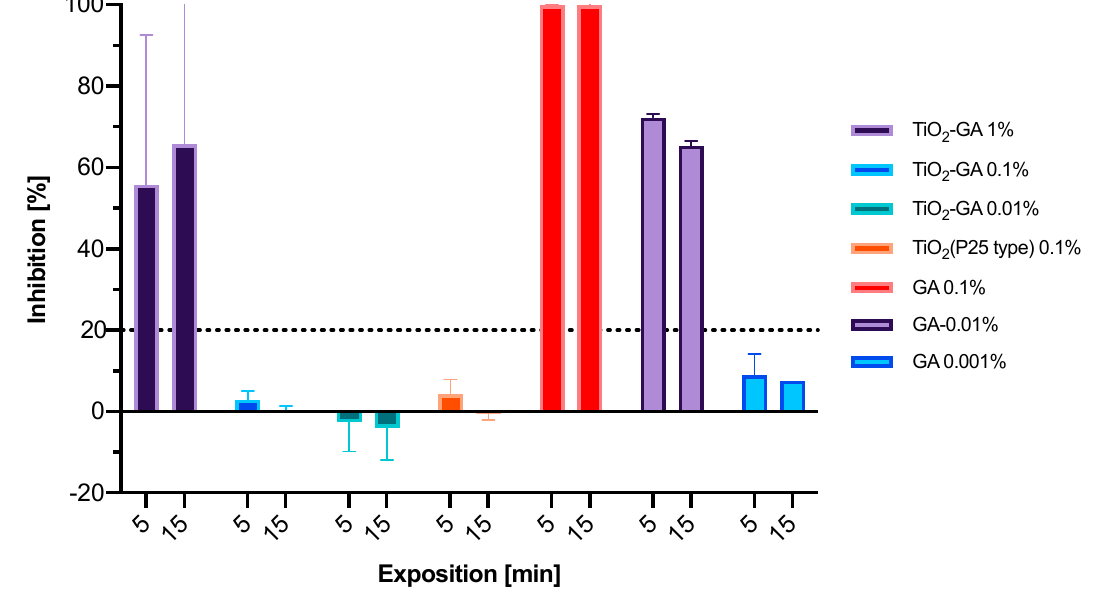
Figure 8. A. fischeri bioluminescence inhibition upon incubation with solutions/suspensions of the tested materials (mean values ± standard deviation). The dashed line represents the 20% threshold, the arbitrary value of compound toxicity. All experiments were performed in triplicate.